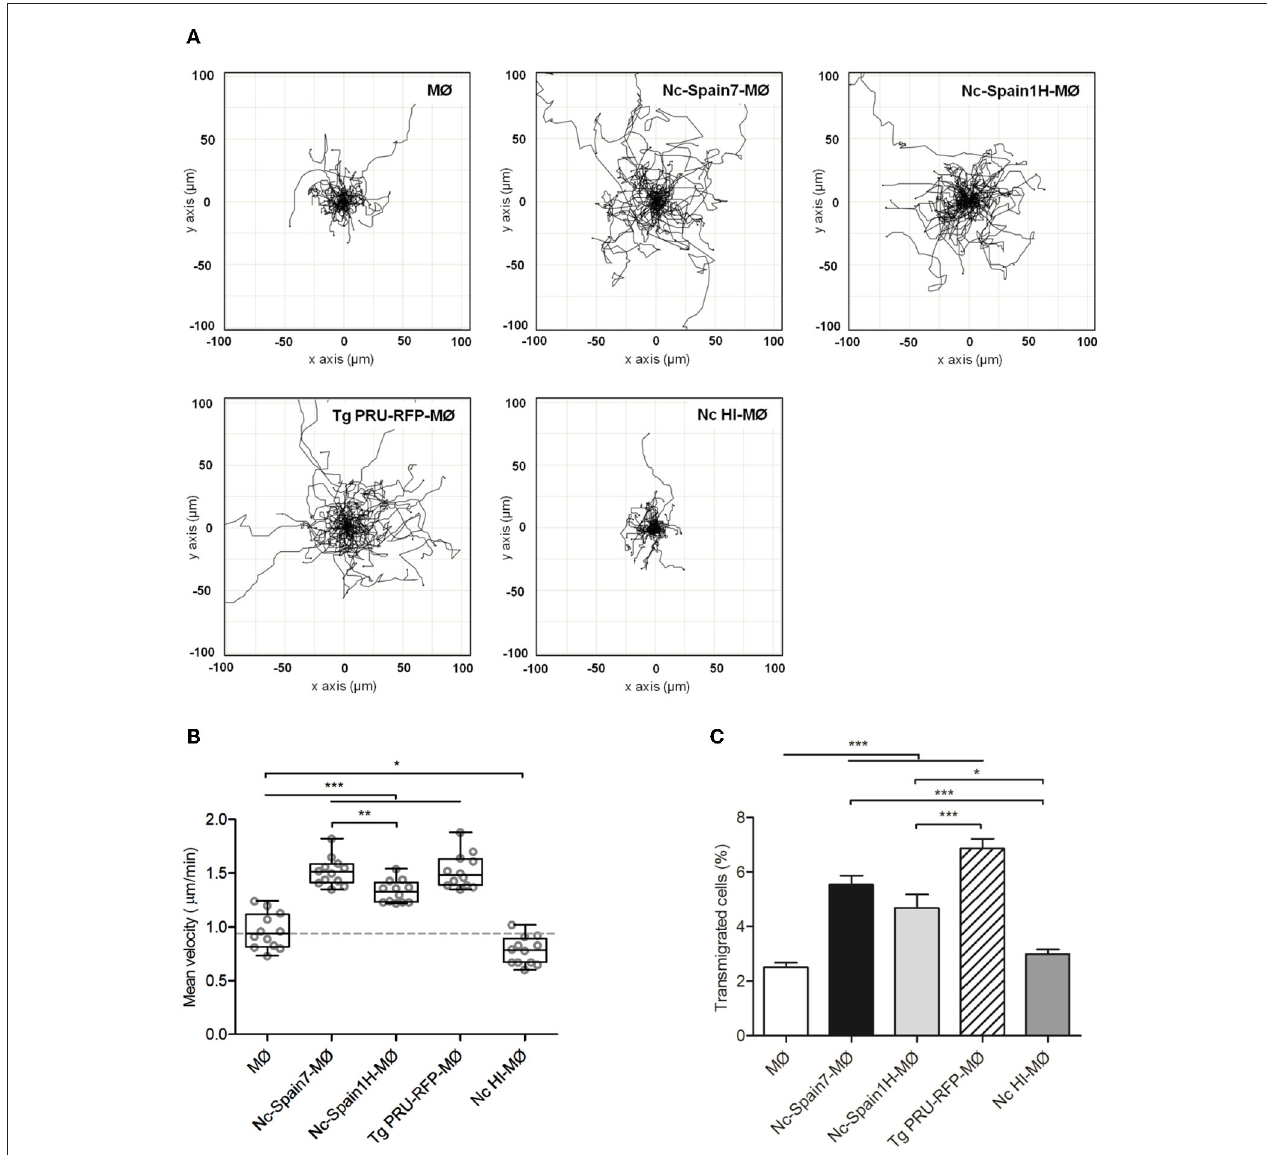
FIGURE 5 | Hypermotile phenotype and enhanced transmigration in bovine MØs induced by N. caninum infection. (A) Motility plot of unchallenged MØs (MØ) and MØs challenged for 4h with N. caninum Nc-Spain7 (Nc-Spain7-MØ), Nc-Spain1H (Nc-Spain1H-MØ), heat-inactivated tachyzoites (Nc HI-MØ) or T. gondii PRU-RFP tachyzoites (Tg PRU-RFP-MØ). (B) Graph represents the mean velocity and SEM of three independent experiments. Circles indicate the average velocity of 50 cells tracked in two different tiles and two different wells per experiment. Box plot shows upper and lower interquartile range with median. (C) The graph represents the percentage of transmigration 18 hpi of MØs, Nc-Spain7-MØs, Nc-Spain1H-MØs, Nc HI-MØs, and Tg PRU-RFP-MØs. The data represent the mean values and SD of three independent experiments; Significant differences are indicated (* p < 0.05; ** p < 0.01; *** p < 0.001).